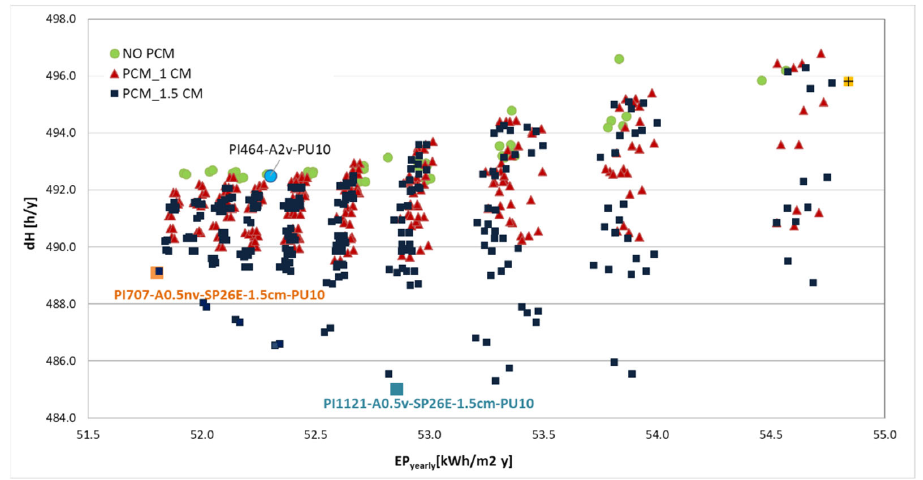
Figure 9. PCMs on external side: comparison based on primary energy need and discomfort hours. The solutions are organized in several vertical distributions; each one is characterized by the same level of insulation but the configurations with the higher thickness of PCM are usually on the bottom of these lines. For instance, the first distribution on the right, where the base case is also highlighted, is composed of all solutions with the lower insu ‐ lation level on the internal and external side. Herein, there is PI 0140 ‐ A 5nv ‐ RT26 ‐ 1cm ‐ PU6 characterized by the lower energy demand ( EP yearly = 54.5 kWh/m 2 y) and dH = 490.8 h/y and PI 0140 ‐ A 4.5nv ‐ SP26E ‐ 1.5cm ‐ PU6 with the lower discomfort hours (dH = 489.5 h/y) and